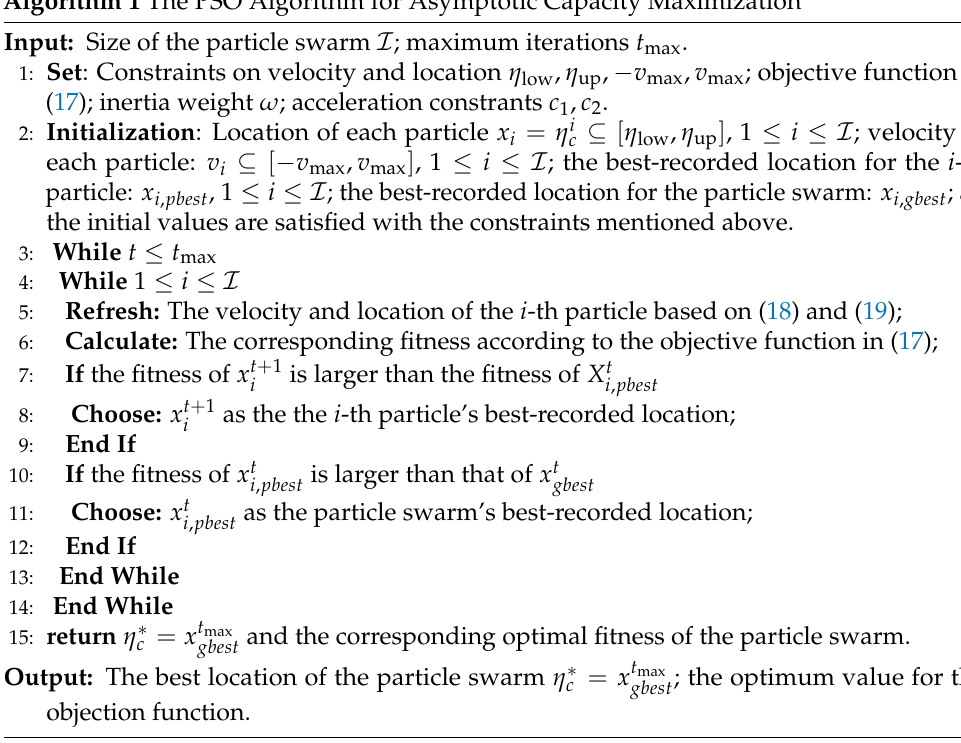
Algorithm 1 The PSO Algorithm for Asymptotic Capacity